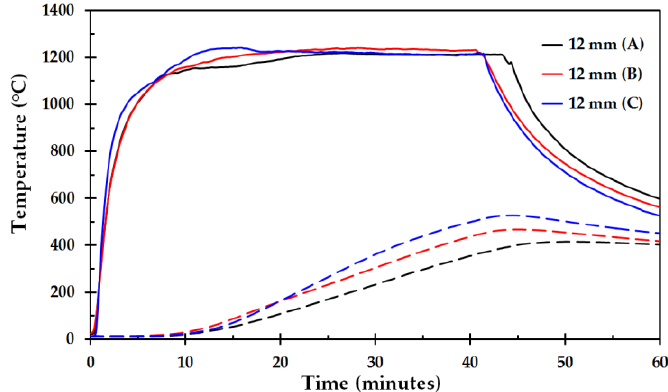
Figure 7. Temperature as a function of time for 12 mm thick steel plate, test A, B and C. Solid lines represent the plate thermometer temperature while the dashed lines represent the temperature of the exposed steel plates.